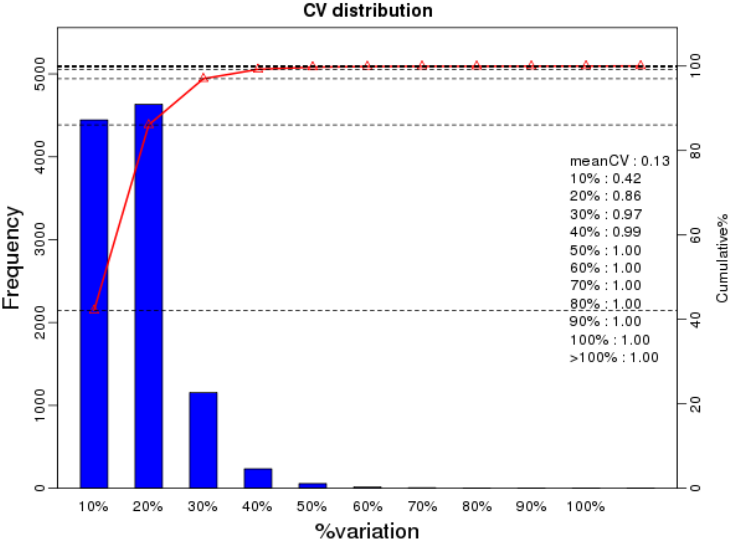
Figure 2. Repeatability analysis of the phosphopeptide quantification founded on the value of CV (coefficient of variation). The x -axis represents the percentage values of CV. The quantities of phosphopeptides and the accumulative proportion of phosphopeptides are indicated by the left and right y -axis, respectively.